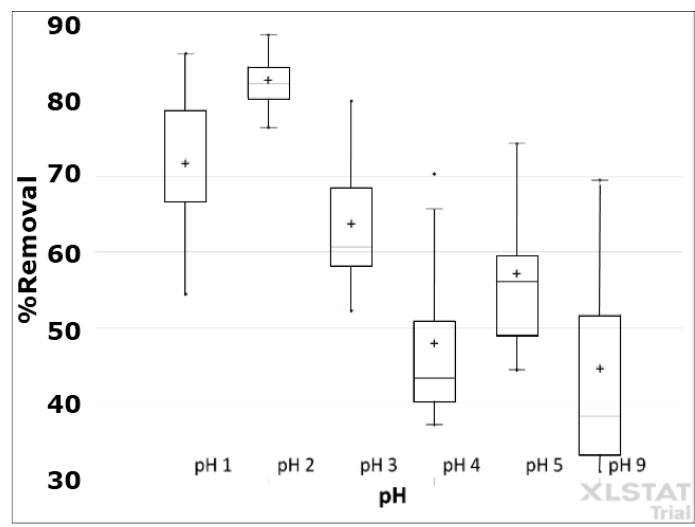
Figure 4. Box plots of Cr (VI) at different pH, obtained from XLSTAT software.